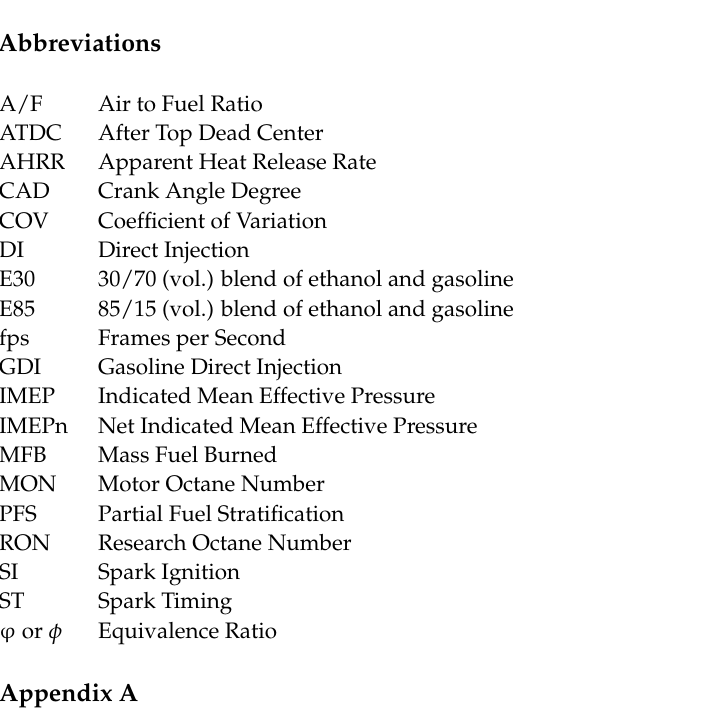
the entrance slit (open at 250 µ m) of an Acton SP2300 spectrometer with 300 mm focal length and 150 groove/mm grating (central wavelength 350 nm). The spectrometer was coupled with an intensified CCD (Charge-Coupled Device) camera: PI-MAX3 (Princeton Instruments) with an array size of 1024 × 1024 pixels, pixel size of 13 × 13 µ m and